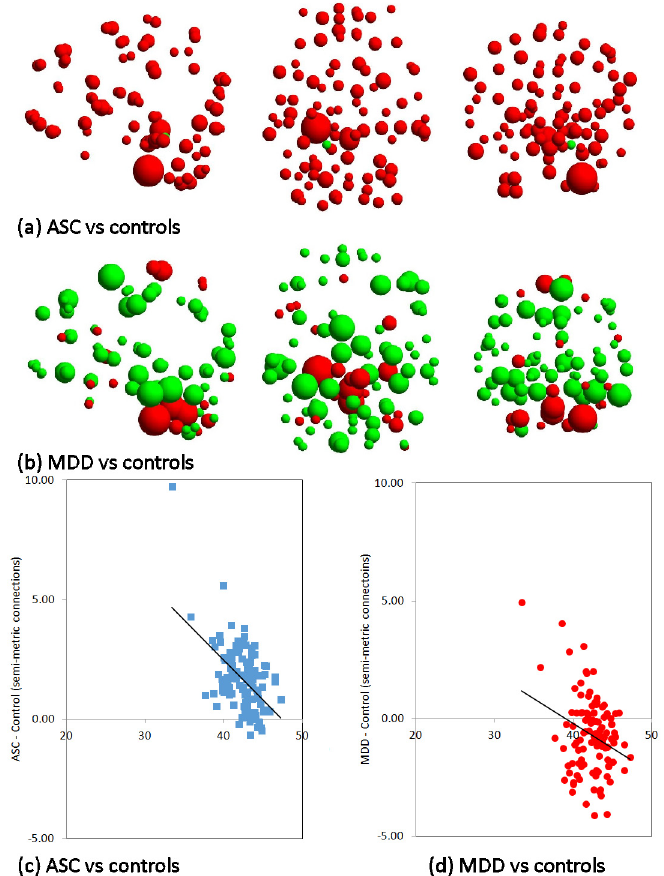
Fig 3. Node degree and node disruption indices. Sagittal, axial and coronal projections (left-to-right) of nodes for comparisons of node degree in the semi-metric network for each between-group comparisons: (a) ASC vs. controls; (b) MDD vs controls. The radius of the node is proportional to the average degree difference and the colour denotes the direction of the effect; red indicating increases and green decreases, relative to controls. Plots of the difference in mean degree between (c) ASC and (d) MDD, and controls against mean degree for controls, for the semi-metric network. Node disruption indices are defined as the slope of the regression lines, plotted on each